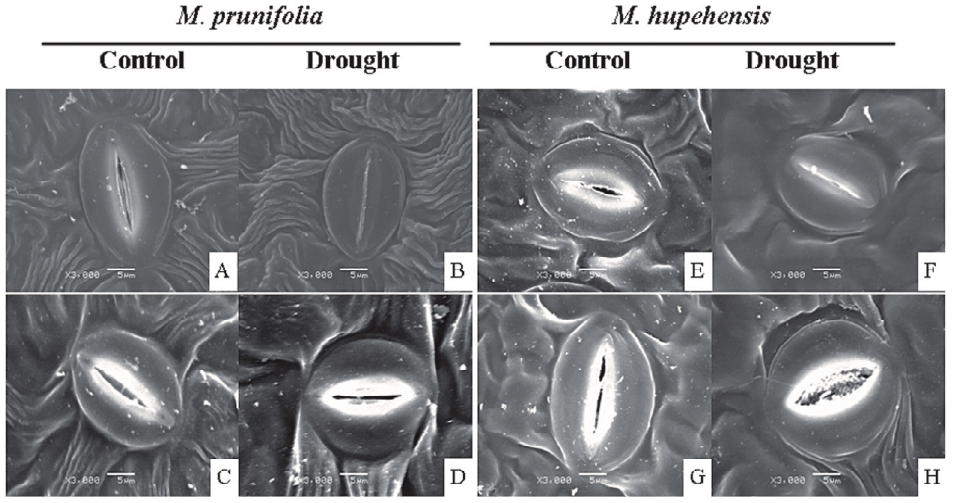
Figure 4. Scanning electron micrographs of stomata of leaves from M. prunifolia and M. Hupehensis plants. A and E = open stomata of control leaves; B and F = closed stomata from leaves subjected to 5 days of drought; C and G = open stomata of control leaves after treatment with 100 µM melatonin; D and H = open stomata of leaves from drought-stressed plants pretreated with melatonin. From Li et al. [133] with